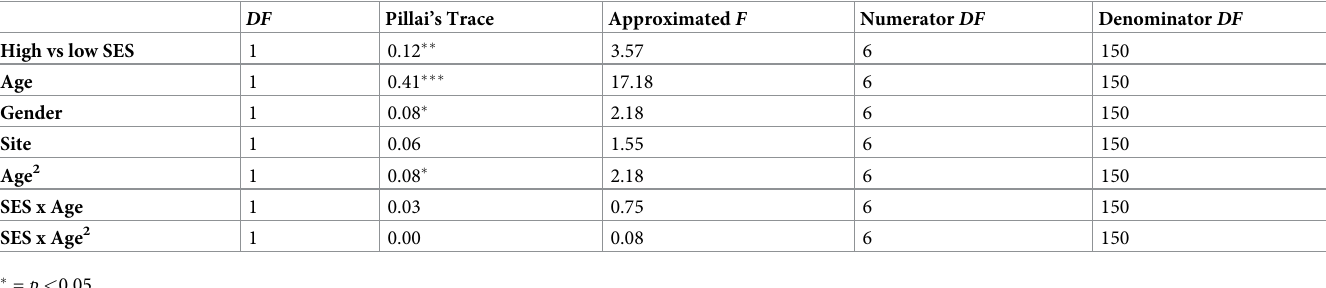
Table 3. MANCOVA as a function of low and high SES ( N =